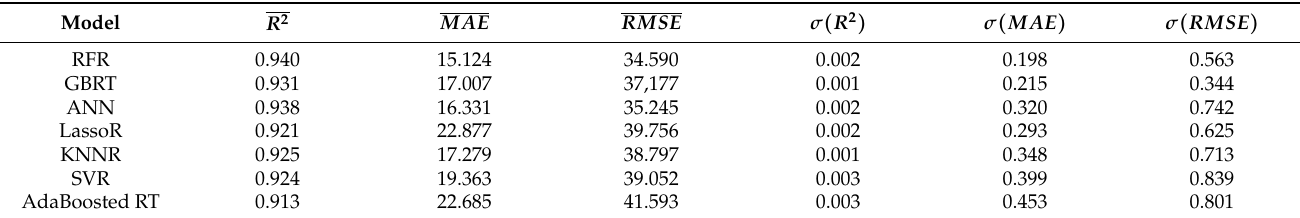
Table 3. A comparison of the performance between the proposed